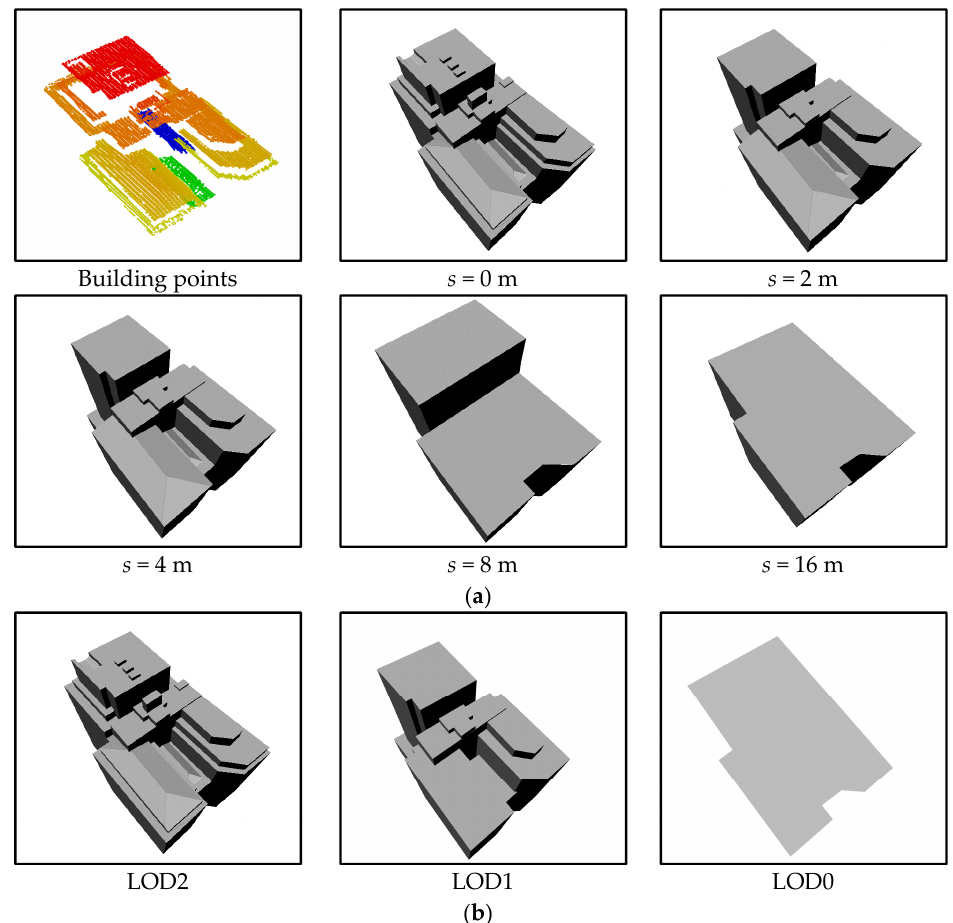
Figure 19. Comparison of LoDs from CityGML and the proposed method for a building with multiple stories. ( a ) Building LoDs from the proposed method; ( b ) Building LoDs from CityGML.